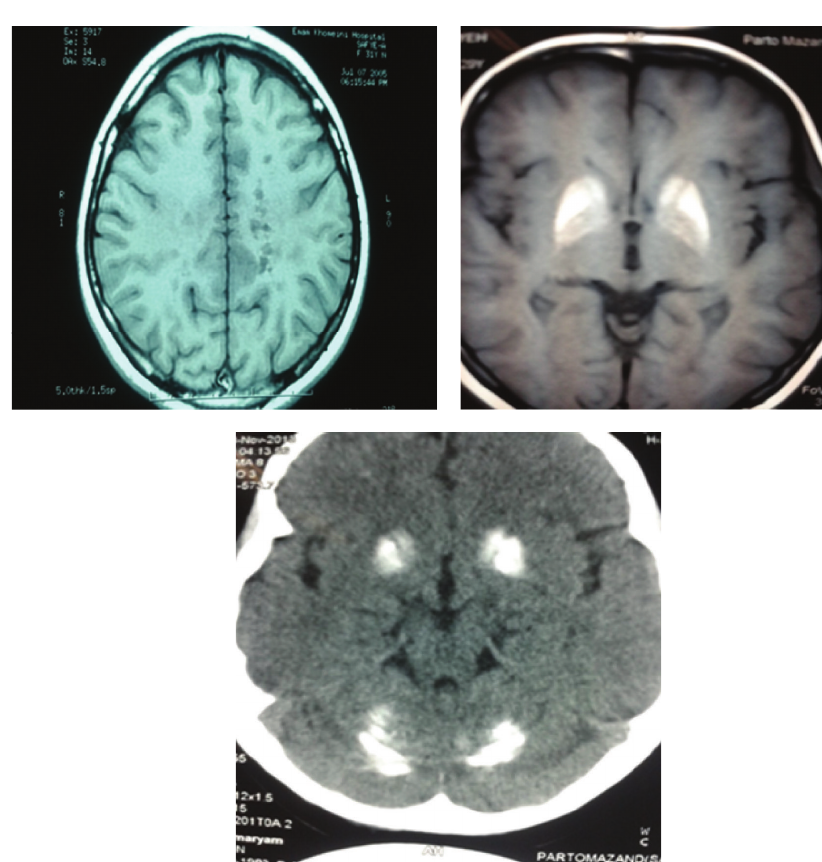
Figure 2: T1 MRI: black hole and basal ganglia calcification at upper side. CT scan: BG and cerebellar calcification at lower side.